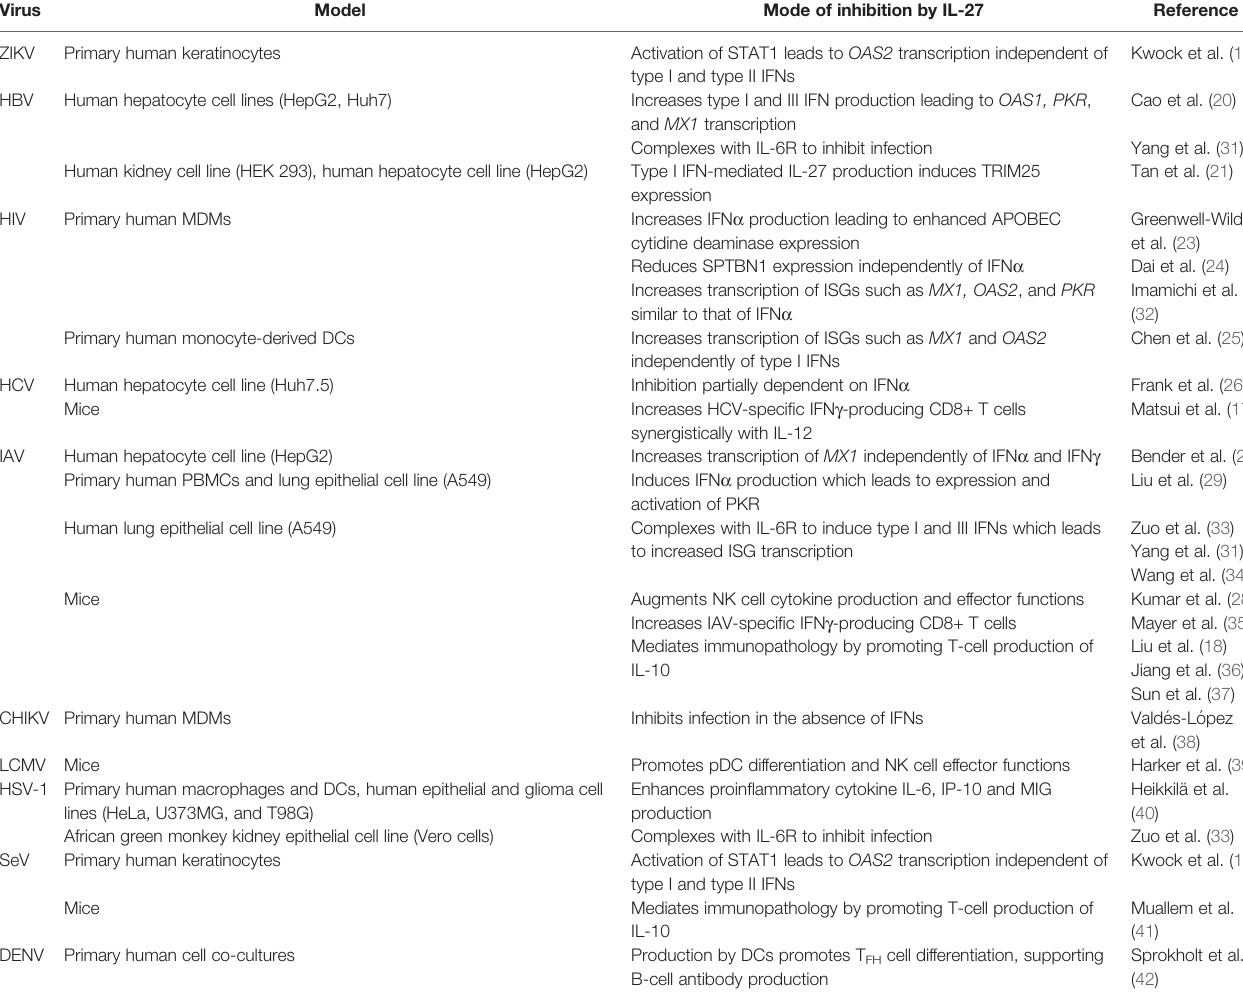
TABLE 1 | Evidence of IL-27 inhibition of viral